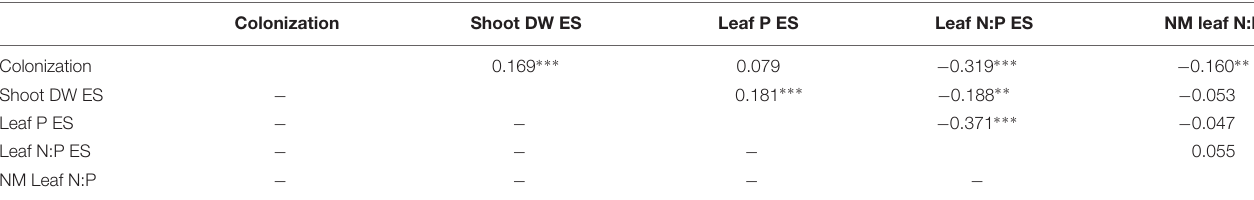
TABLE 3 | Correlation analysis of regression